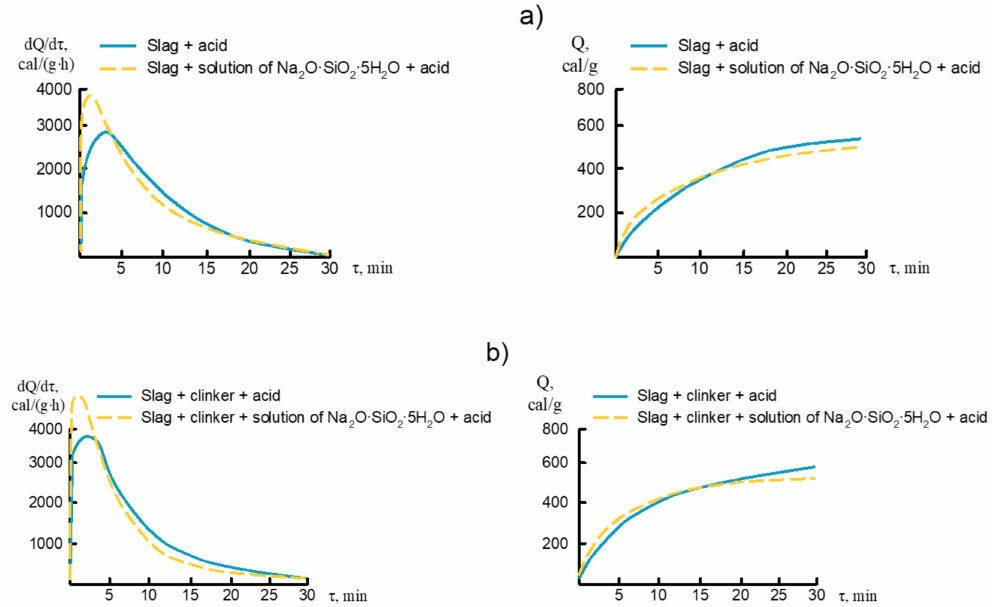
Figure 8. Interrelationships dQ/d τ − f( τ ) and Q − f( τ ) in the process of dissolution of the unhydrated ( a ) and hydrated cement samples ( b ). The “cement + acid” is unhydrated and “cement + water glass + acid” is